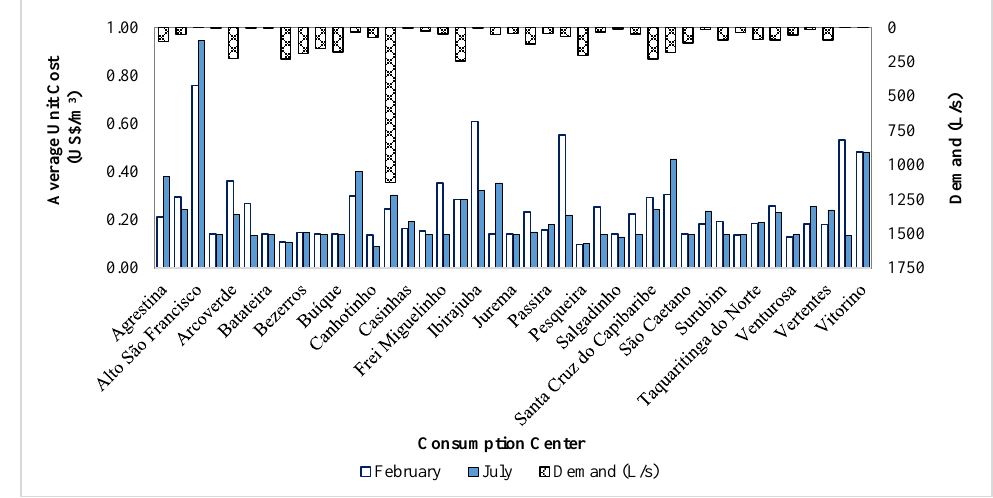
Figure 9. Average unit cost for supplying consumption centers in February and July.